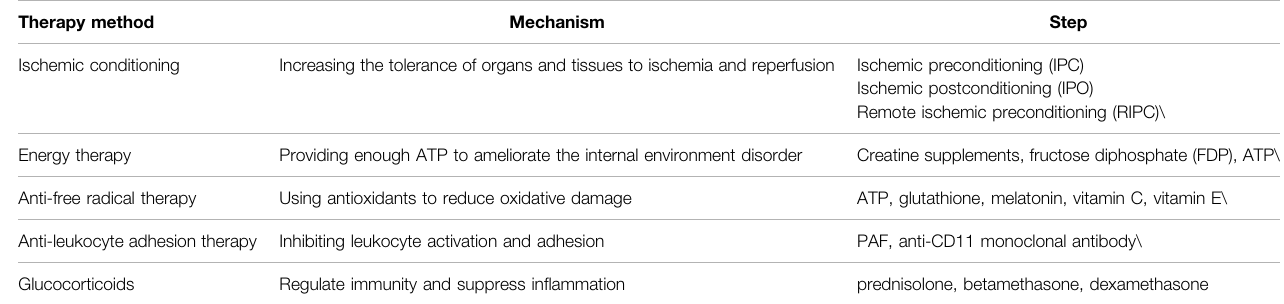
TABLE 1 | Ways of prevention and treatment of intestinal ischemia/reperfusion injury. Therapy method Ischemic